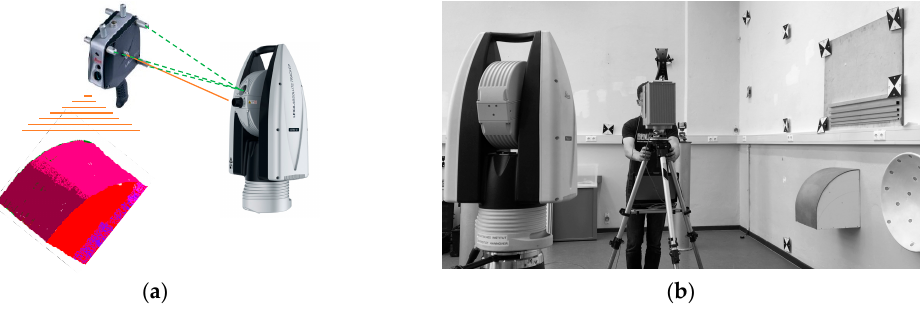
Figure 13. Scan of reference geometries using ( a ) Leica T-Scan 5 and AT960 LR and ( b ) MSS.